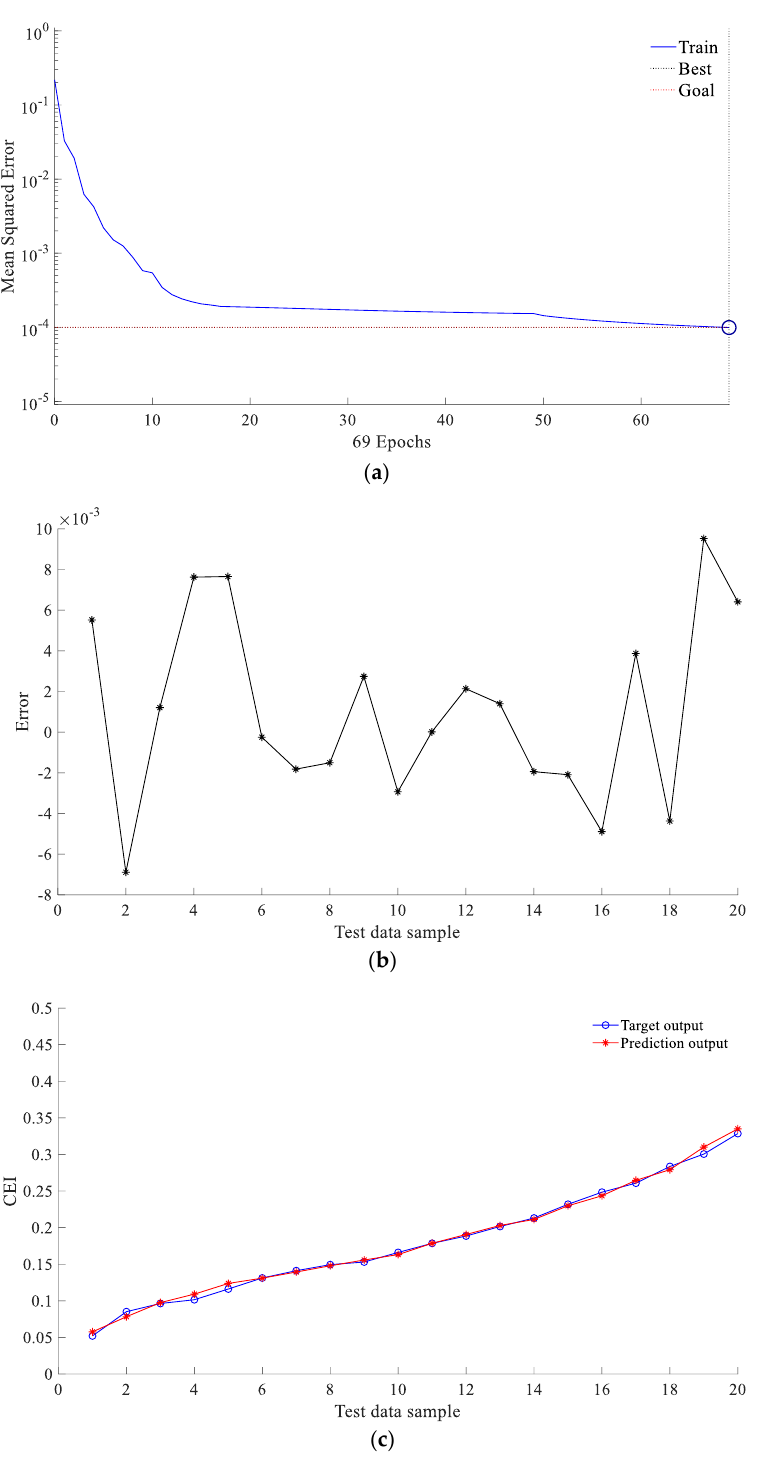
Figure 7. The analysis diagram of the accuracy of CEI constructed by BP neural network: ( a ) the iterative accuracy curve of the BP neural network; ( b ) the prediction error of the BP neural network; ( c ) the comparison result between the predicted output of the BP neural network and the target output.